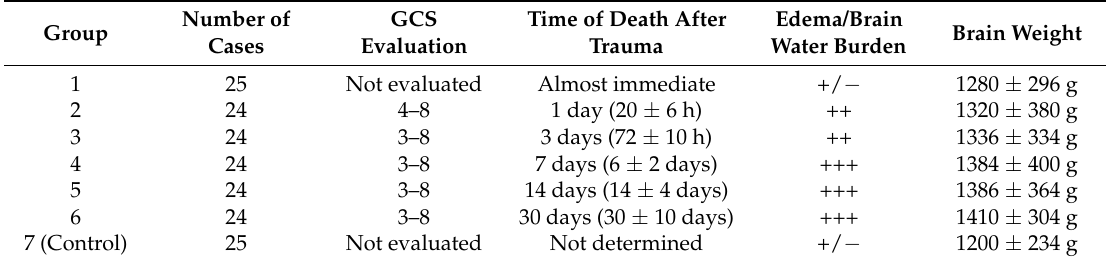
Table 1. Brain weight and computed tomography (CT) determination of edema/brain water burden.